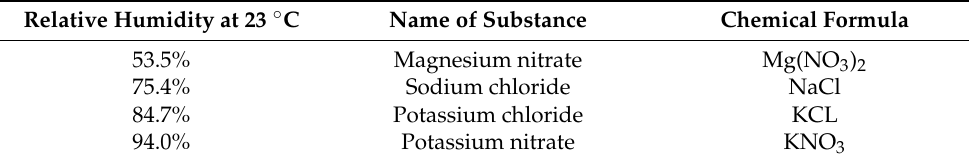
Table 3. Chemicals used for the preparation of the saturated